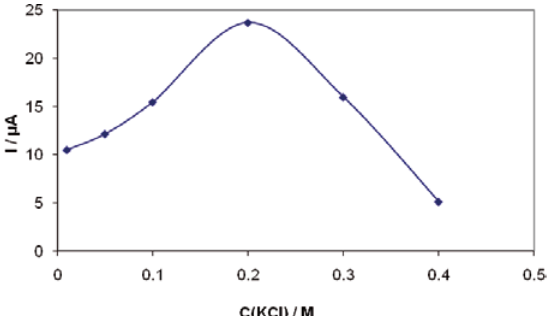
Figure 4. Variation of the Ep of Piroxicam (9.9 × 10 -6 M) with pH scan rate of 50 mV s -1